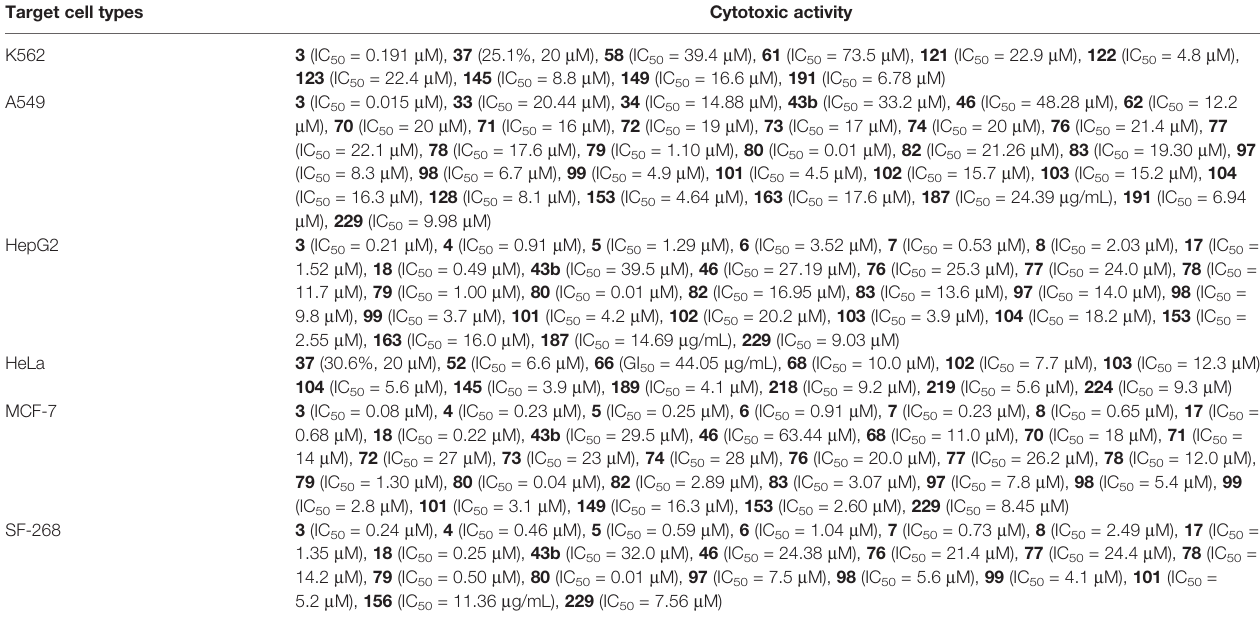
TABLE 1 | Target cell types and cytotoxic activity of the isolated